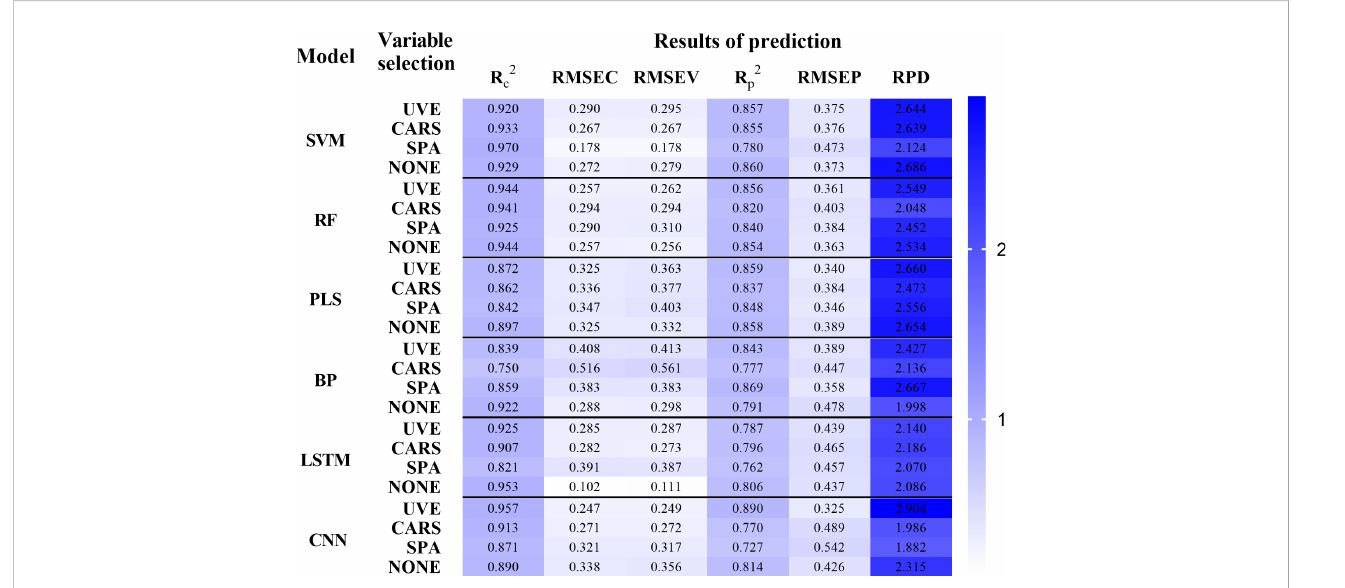
FIGURE 7 Prediction results of the tea plant low temperature response index (LTRI) model based on the characteristic bands selected by different variable selection